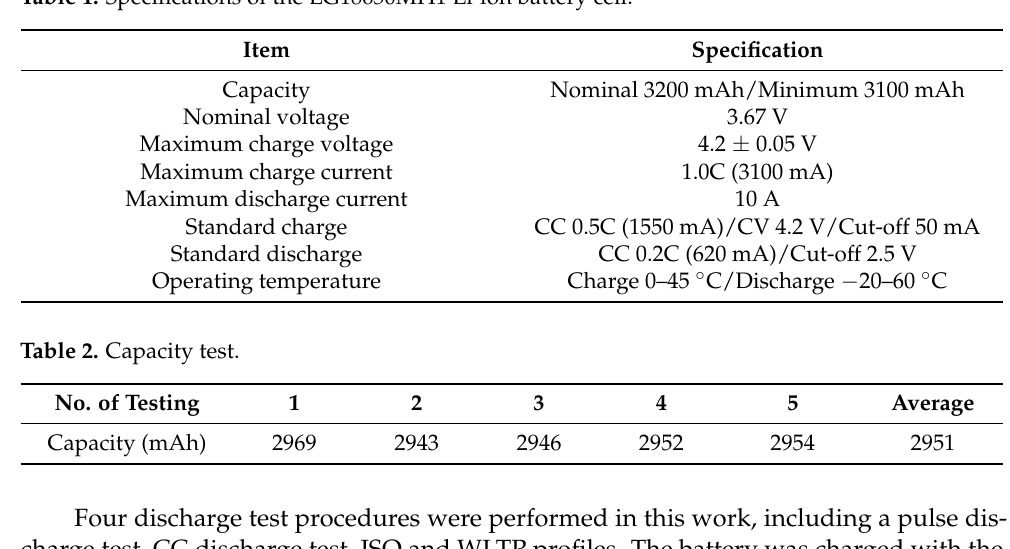
Figure 1. The schematic of the battery test bench. Table 1. Specifications of the LG18650MH1 Li-ion battery cell. Table 1. Specifications of the LG18650MH1 Li-ion battery cell.